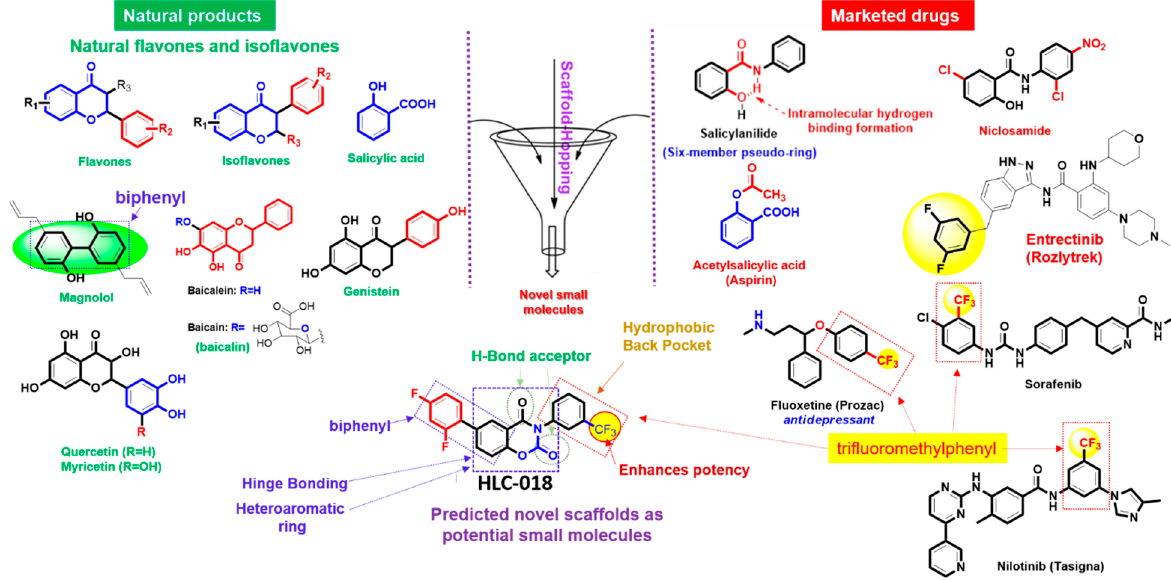
Figure 8. Scaffold-hopping of bioactive natural products and marketed drugs for the discovery of HLC-018. Scaffold-hopping of bioactive natural compounds (flavones and isoflavones), biphenyl, trifluoromethylphenyl, and niclosamide lead to the discovery of a novel small molecule, 6-(2,4-difluorophenyl)-3-(3-(trifluoromethyl)phenyl)-2H-benzo[e][1,3]oxazine-2,4(3H)-dione (HLC-018).